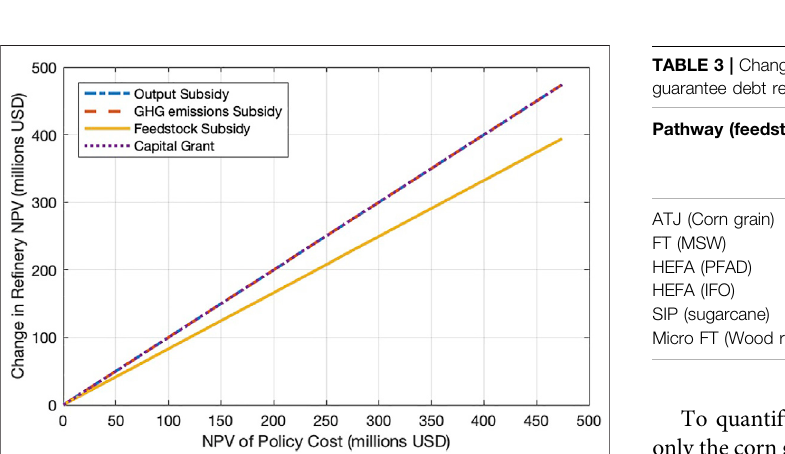
FIGURE 2 | Real-world policy effects on MSPs for pathways. Details on the individual policies are listed in the Methods and Materials Section.